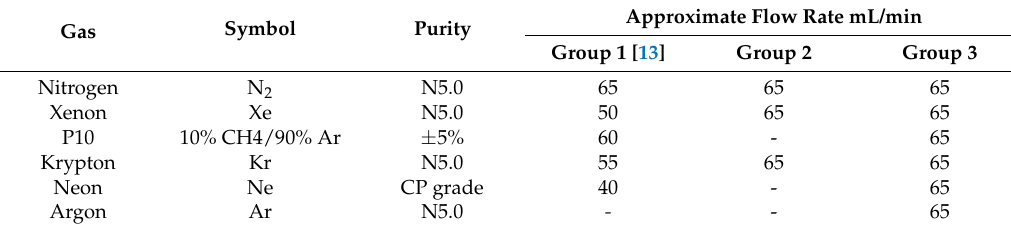
Table 1. Table of gases showing flow rates and experiment